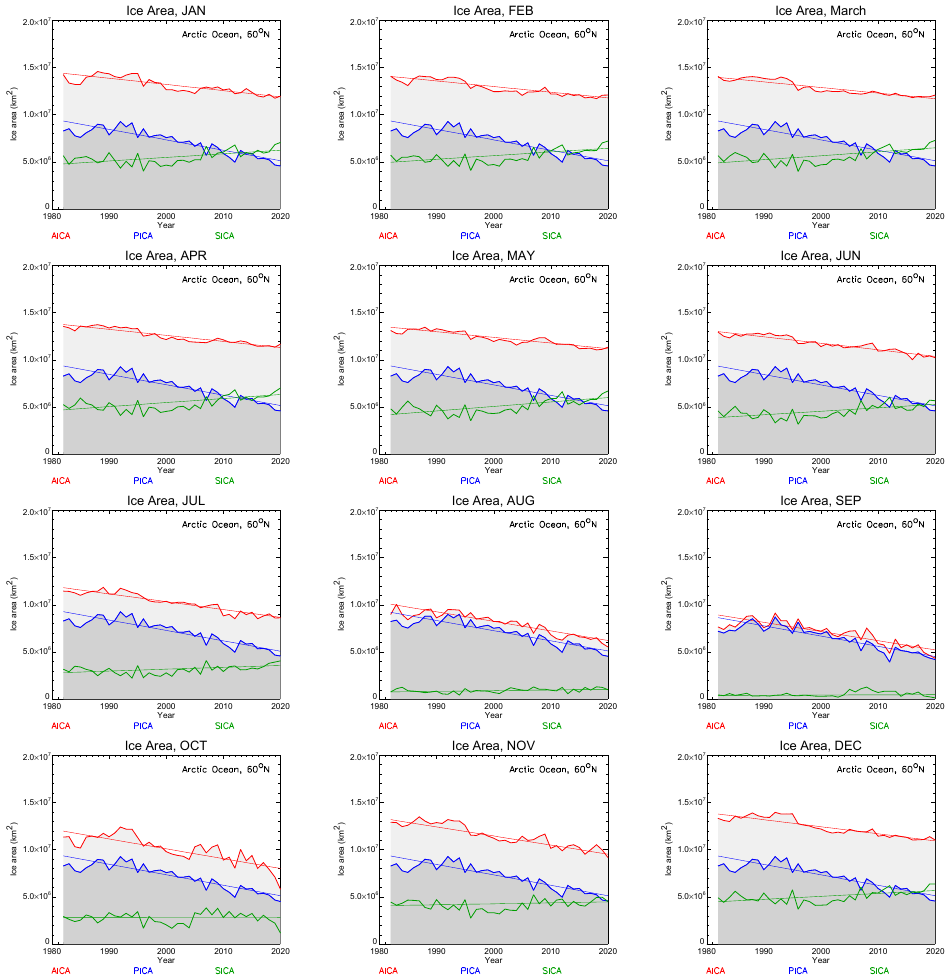
Figure 3. SIE time series for the Arctic area north of 60°N over 1982–2020 for the months of January through December. PICA (blue) stands for perennial ice-covered area, SICA (green) denotes seasonal ice-covered area, and AICA (red) designates all ice (PICA + SICA) covered area. As a combined result, the SIE over AICA in March declined to 1.21076 × 10 7 km 2 in 2020 from 1.41279 × 10 7 km 2 in 1982, resulting in a 14% decrease at a rate of − 5.947 × 10 4 km 2 per year (Table 1). In September, the SIE over AICA is 4.32892 × 10 6 km 2 in 2020, down from 7.63860 × 10 6 km 2 in 1982, resulting in a 43% decrease at a rate of − 9.719 × 10 4 km 2 per year when the ice retreats most, indicating more rapid ice area loss in summer. On